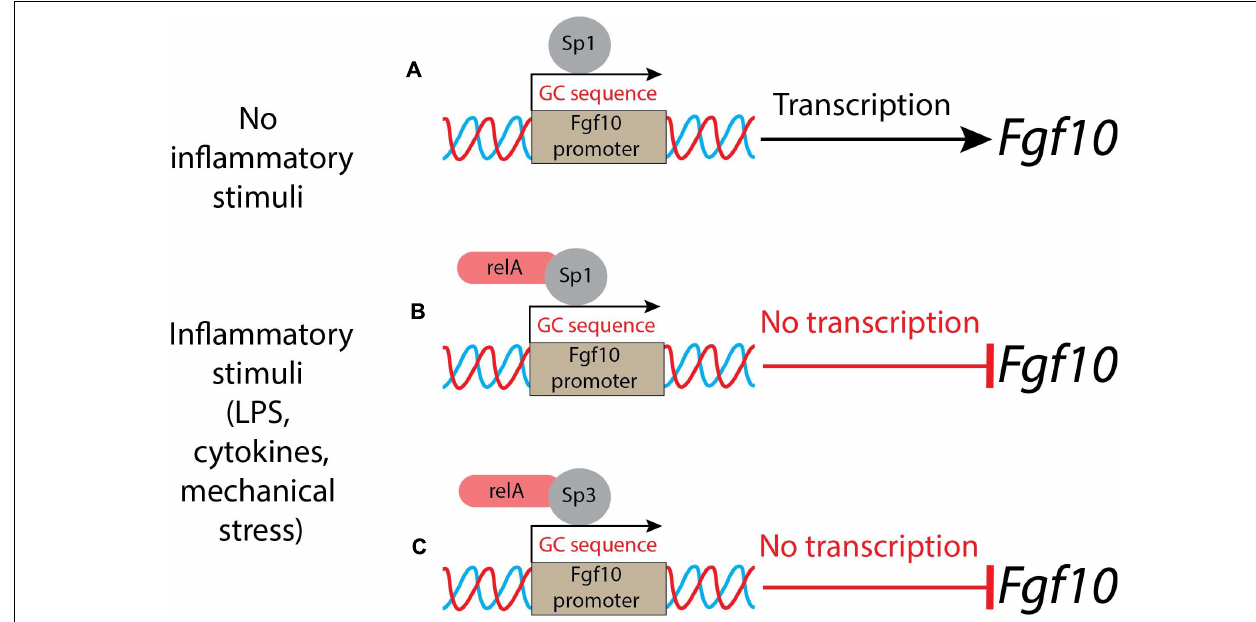
FIGURE 1 | A schematic representation of control of Fgf10 expression during lung morphogenesis. (A) In normal conditions (no inflammatory stimuli), Sp1 binds the Fgf10 promoter leading to the transcription of the growth factor; (B) in presence of inflammatory stimuli, the relA subunit of NF- κ B translocates into the nucleus and binds Sp1, acting as a repressor; (C) alternatively, the relA subunit of NF- κ B interacts physically with Sp3 and the complex competes with Sp1: the result is a suppression of Fgf10 transcription.